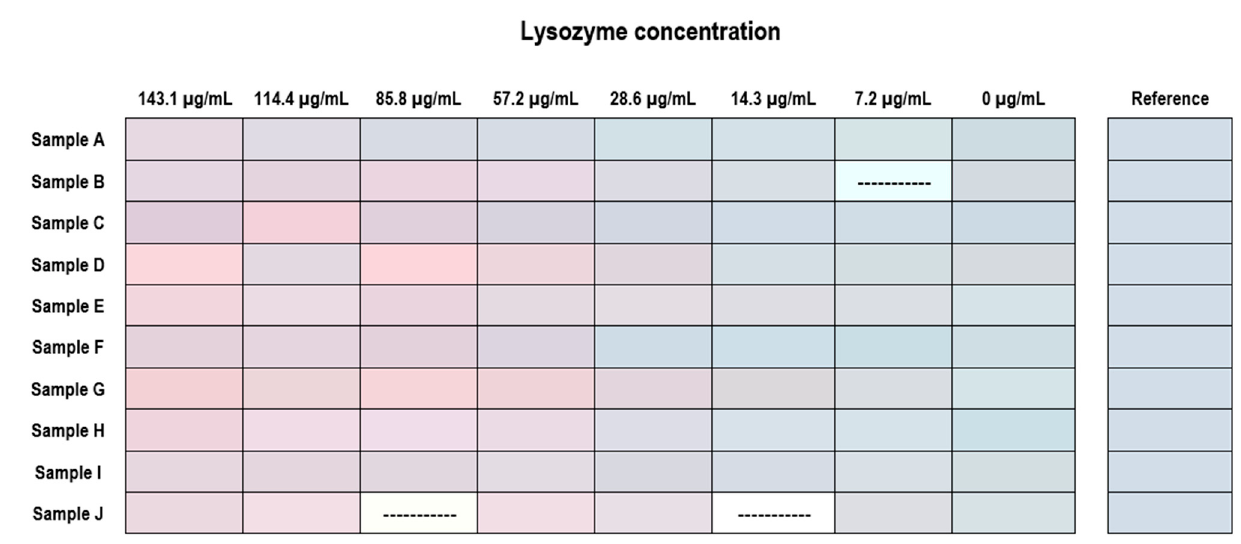
Figure 7. RGB color simulation obtained from experimental L*a*b* parameters corresponding to different lysozyme concentrations in